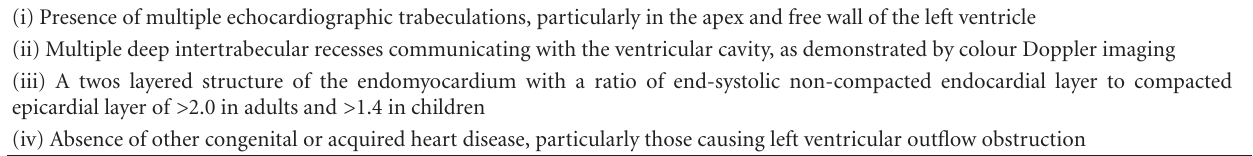
Table 1: Echocardiographic criteria for diagnosis of IVNC.